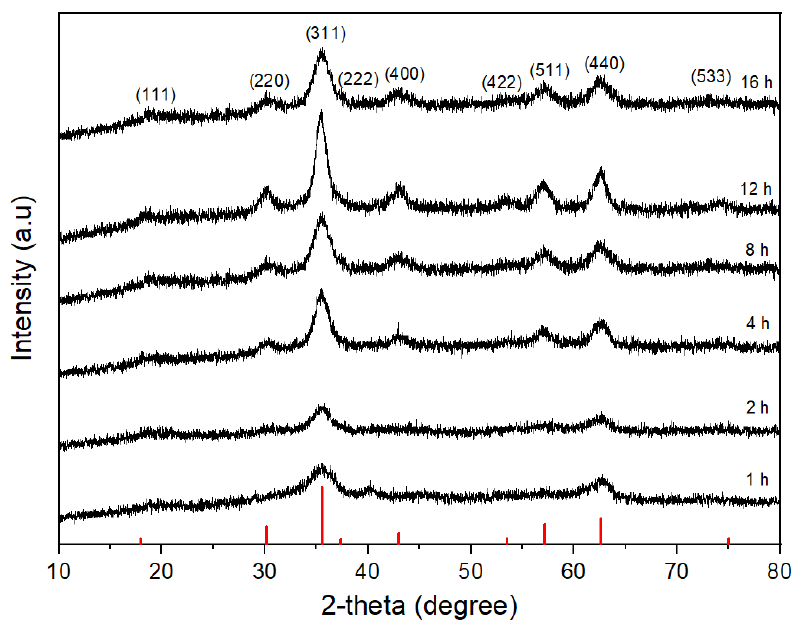
Figure 1. XRD patterns of CoFe 2 O 4 nanoparticles synthesized at 180 °C in the presence of 1 M oleic acid for different reaction times.